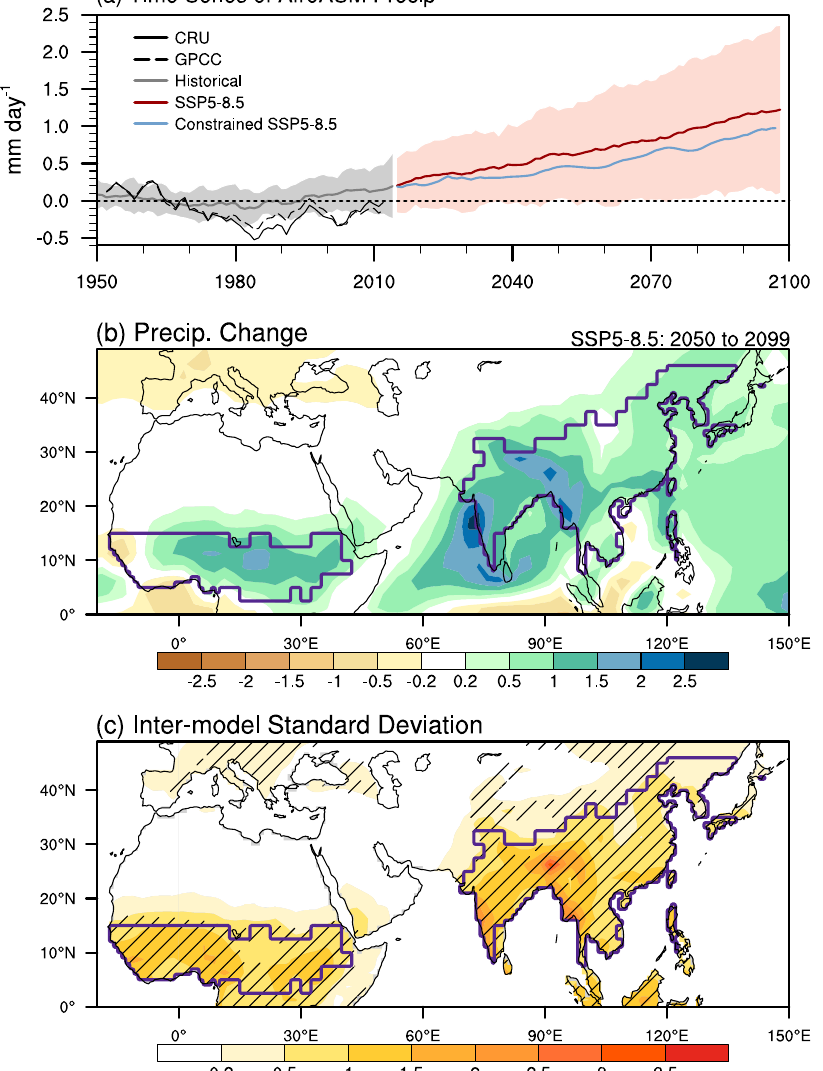
Fig. 1 Projected changes in the Afro-Asian summer (June, July, August, and September) monsoon (AfroASM) precipitation and uncertainty of the projected changes. a Time series of 5-year running mean of AfroASM precipitation anomalies (units: mm day − 1 ), relative to 1950~1980 mean. Historical (gray) and SSP5-8.5 (red) simulations are shown for the 5 th and 95 th percentiles across 30 models (shading), and the ensemble mean (thick solid lines). The blue solid line is the AfroASM precipitation anomalies after emergent constraint. The black solid and dash lines are the observational series from the Climatic Research Unit (CRU) Time-Series (TS) version 4.02 and Global Precipitation Climatology Centre version 7 (GPCC v7), respectively. b Changes in precipitation (units: mm day − 1 ) under SSP5-8.5 scenario (2050 – 2099) relative to historical simulation (1965 – 2014). The region surrounded by the contour is the Afro-Asian monsoon region (see Methods). c The inter-model standard deviation ( σ ) of projected precipitation changes. Hatched regions denote signal-to-noise ratio between the absolute value of projected changes and the standard deviation less than 1.5. The regions where precipitation changes are lower than 0.1 mm day − 1 or over ocean is